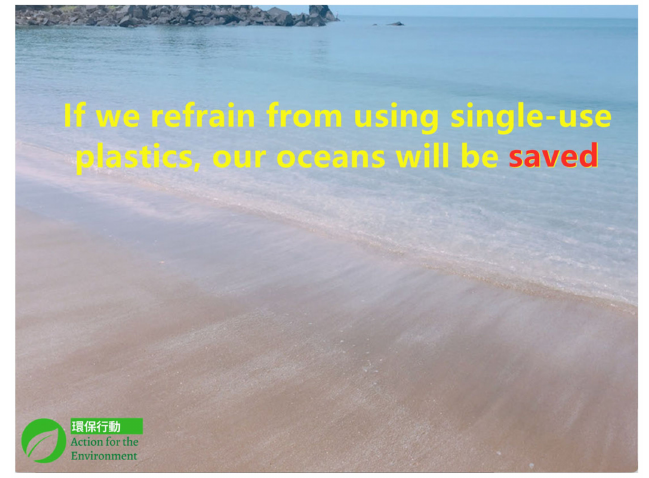
Figure A6. Example of condition 6: gain * image *